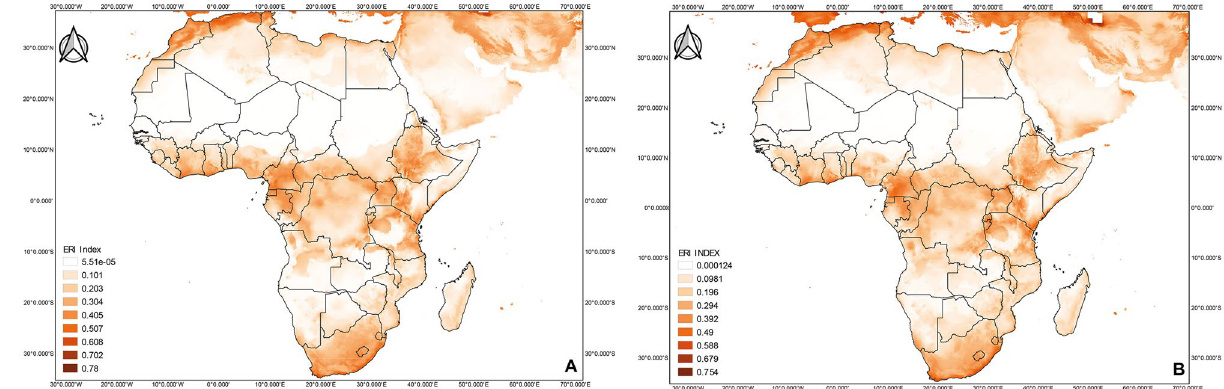
Figure 8. Maxent and BIOCLIM average model plots depicting African continent ( A ) current (2019) and ( B ) future (2050) potential establishment of Trialeurodes